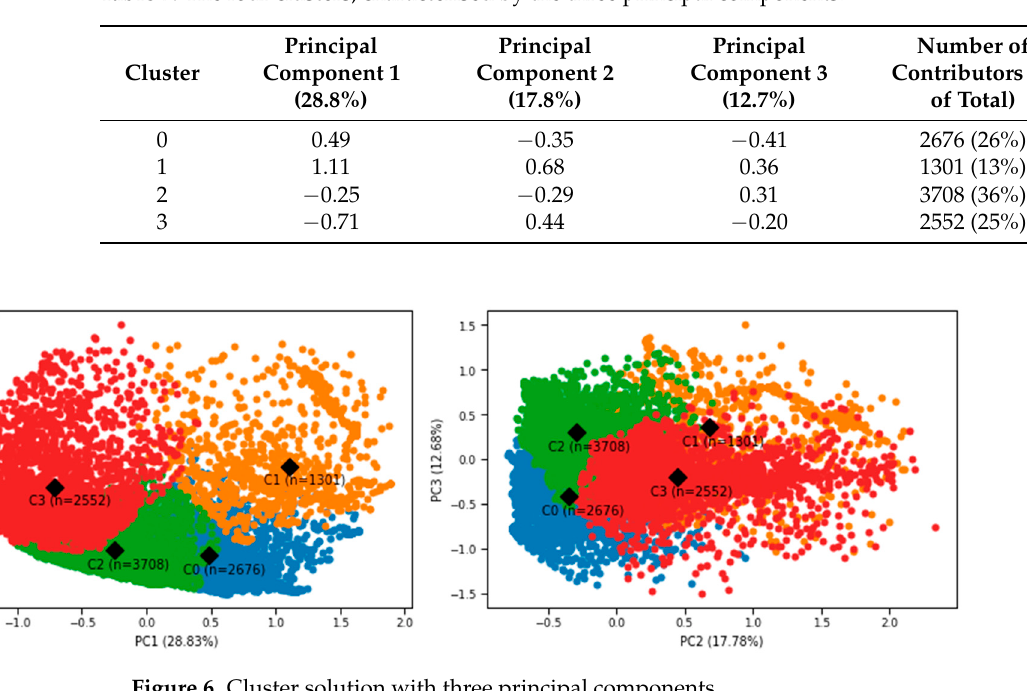
Figure 7. Cluster solution with six principal components. Table 7. The four clusters, characterised by the three principal components. Cluster